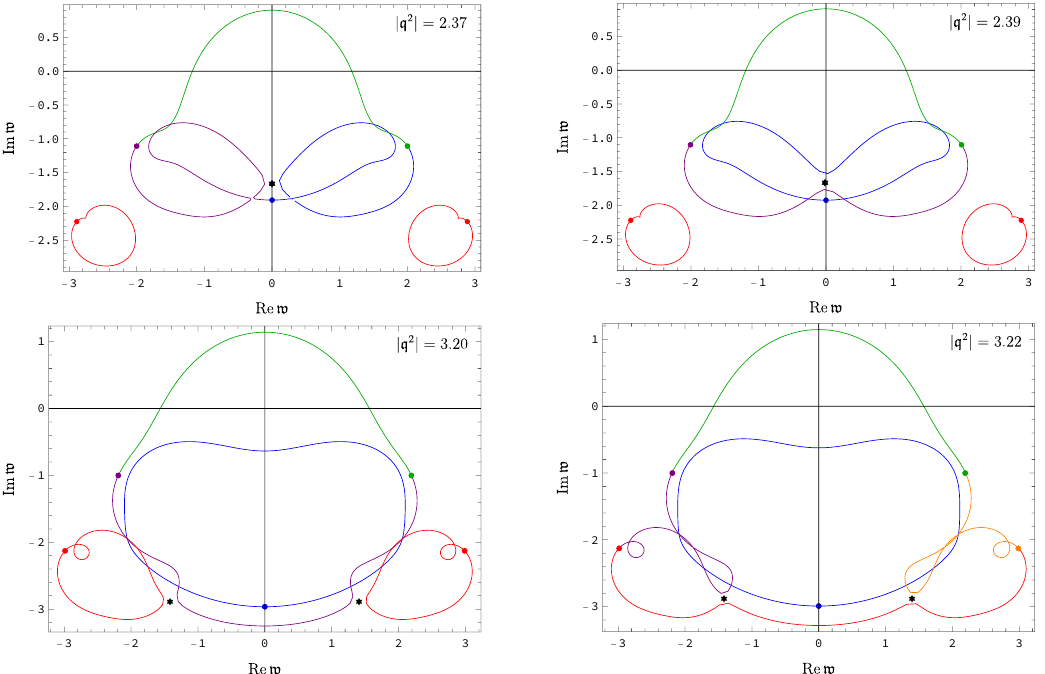
Figure 8 . Quasinormal spectrum (poles of the retarded energy-momentum tensor two-point func- tion in the N = 4 SYM theory) in the shear channel plotted in the complex w -plane for di(cid:11)erent values of the complex momentum q 2 = j q 2 j e i(cid:18) . Large dots in all four plots correspond to the lo- cation of the poles for purely real momentum, q 2 (i.e. at (cid:18) = 0) [41]. The second critical point (occuring at j q 2 j (cid:25) 2 : 377) is marked by asterisks in the (cid:12)gures showing the trajectories just before c ; 1 and just after the pole collision (top panels). With j q 2 j further increasing, the second pair of gapped modes becomes involved in the collisions leading to the third critical point at j q 2 panels).